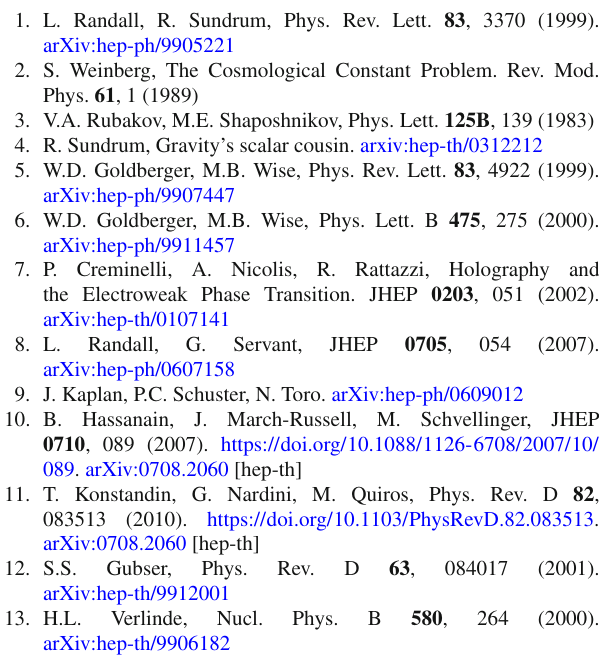
Fig. 12 A comparison between the φ solution in the presence of a horizon and then with no horizon (numerical and analytical). Since the boundary condition for φ at the horizon is the equation of motion itself to leading order, a horizon can be placed at any point along this trajectory which nominally effects φ numerically, and only at next-to- leading-order